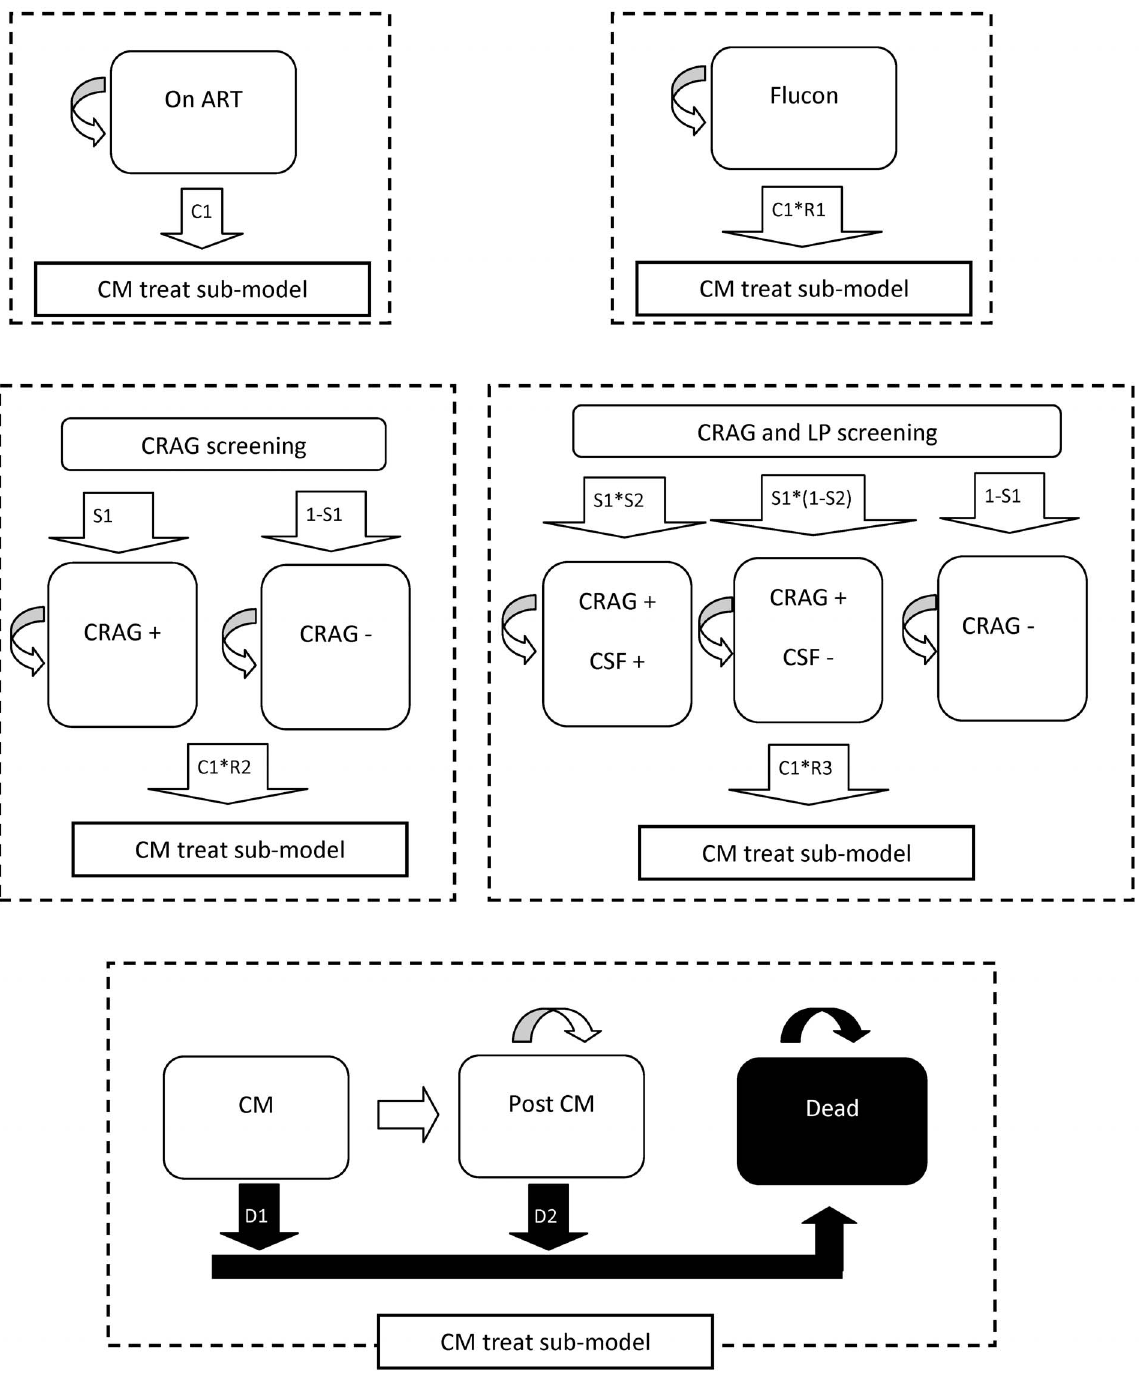
Figure 1. Simplified markov model structure. Transition probabilities are listed as C1, C2, S1 etc. Variable names, descriptions and values are derived from table 1, as follows: S1 - Proportion with subclinical CM at baseline, CD4 , 50 cells/ m L=0.13, CD4 50–100 cells/ m L=0.03. S2 - Of those with subclinical CM, Proportion with CSF infection=0.5. P1 - Proportion starting ART with CD4 , 50 cells/ m l=0.5. C1 - Probability of developing CM, by baseline CD4 category and time on ART: CD4 , 50 cells/ m l= 252 per 1000 patient years (pyo) up to 3 months on ART, 72 per 1000 pyo 4–6 months on ART, 36 per 1000 pyo 7–9 months on ART, 0 per 1000 pyo 10–12 months. CD4 50–100 cells/ m l =56 per 1000 pyo up to 3 months on ART, 16 per 1000 pyo 4–6 months on ART, 8 per 1000 pyo 7–9 months on ART, 0 per 1000 pyo 10–12 months. R1 - Relative risk of CM with low dose fluconazole prophylaxis=0.21. R2 - Relative risk of CM for CRAG positive taking high dose fluconazole prophylaxis=0.1. R3 - Relative risk of CM for CRAG positive with amphotericin for CSF positive patients, fluconazole for CSF negative patients=0. D1 - Probability of dying of acute CM=45% dead at 1 month with CM. D2 - Probability of dying of CM within 1 year=55% dead at 12 months on ART.